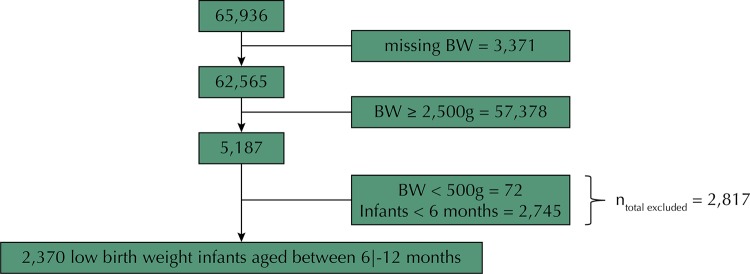
Flowchart representing the population definitions of this study.BW: birth weight